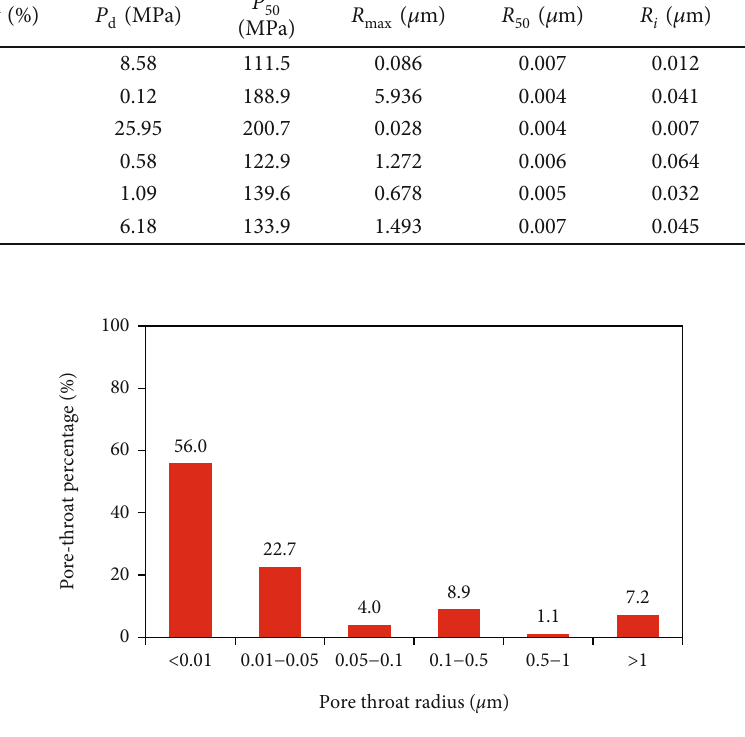
Figure 13: Histogram of pore throat of interlayer core